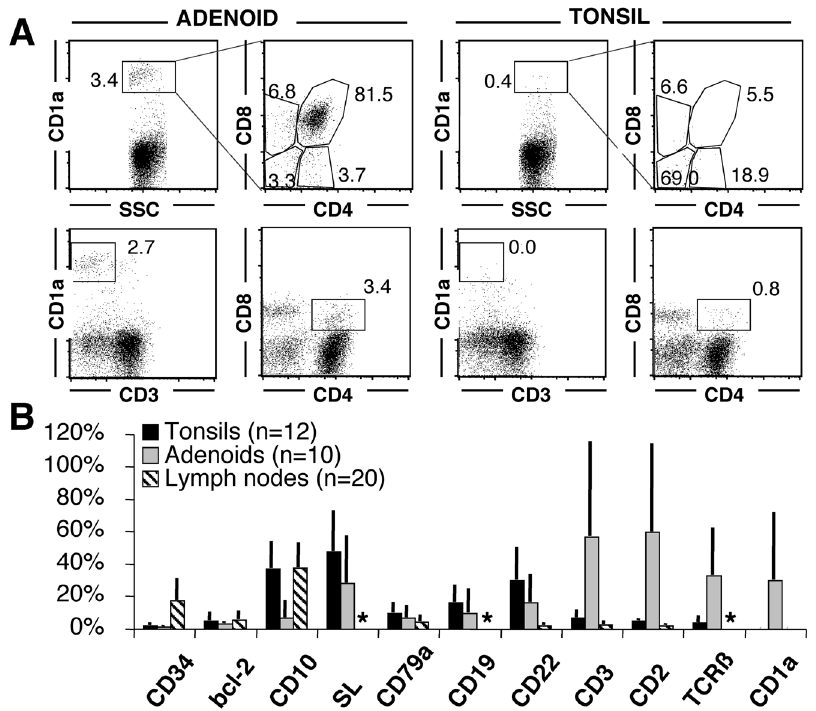
Figure 2. Phenotype of TdT + cells in adenoids, tonsils and secondary lymphoid organs. A: Adenoid and tonsil from the same individual, stained by flow cytometry for surface antigens, show in the adenoid only CD1a + , surface CD3-, double CD4 and CD8 positive immature T cells. The tonsil is devoid of such cells. The numbers indicate the percentage in each gate. CD2 + T cells were enriched by SRBC rosetting. B: The phenotype of TdT + cells in 12 tonsils, 10 adenoids and 20 lymph nodes is plotted. Each marker has been counted on TdT + cells and the mean 6 SD is shown. The variability is due to dilution with TdT + immature B cells. An asterisk marks analysis not done. Note the unique presence of CD1a + immature T cells in